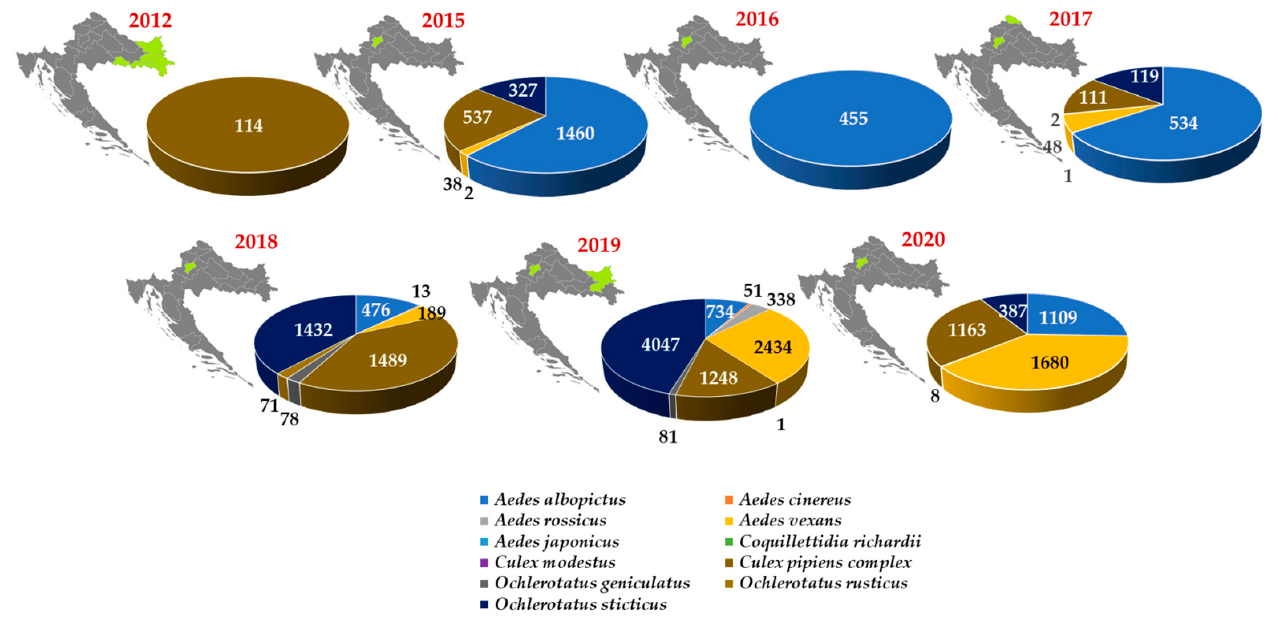
Figure 6. Mosquito sampling counties, number of mosquitoes and species tested for WNV in Croatia, 2012–2020 [43,45,46].